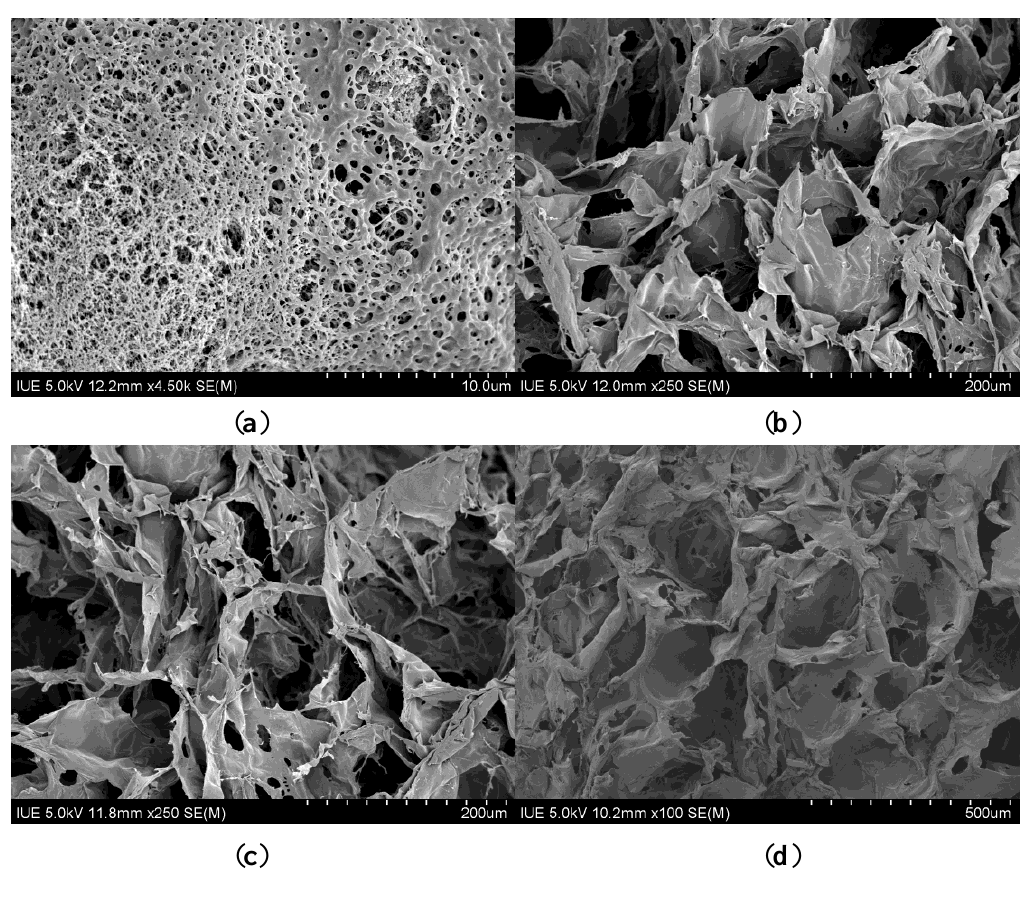
Figure 3. SEM photos of porous sponges with different mean pore sizes of ( a ) 0.1